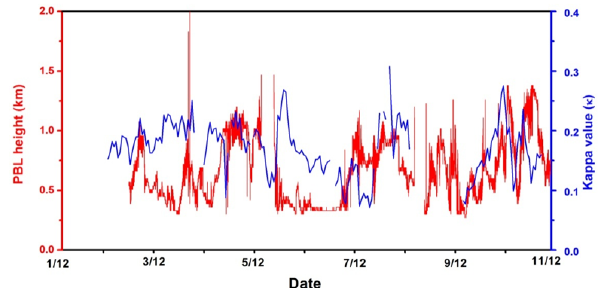
Figure 11. Time series of 1h mean kappa value (i.e., κ) and 5min mean PBL height from 1 to 10